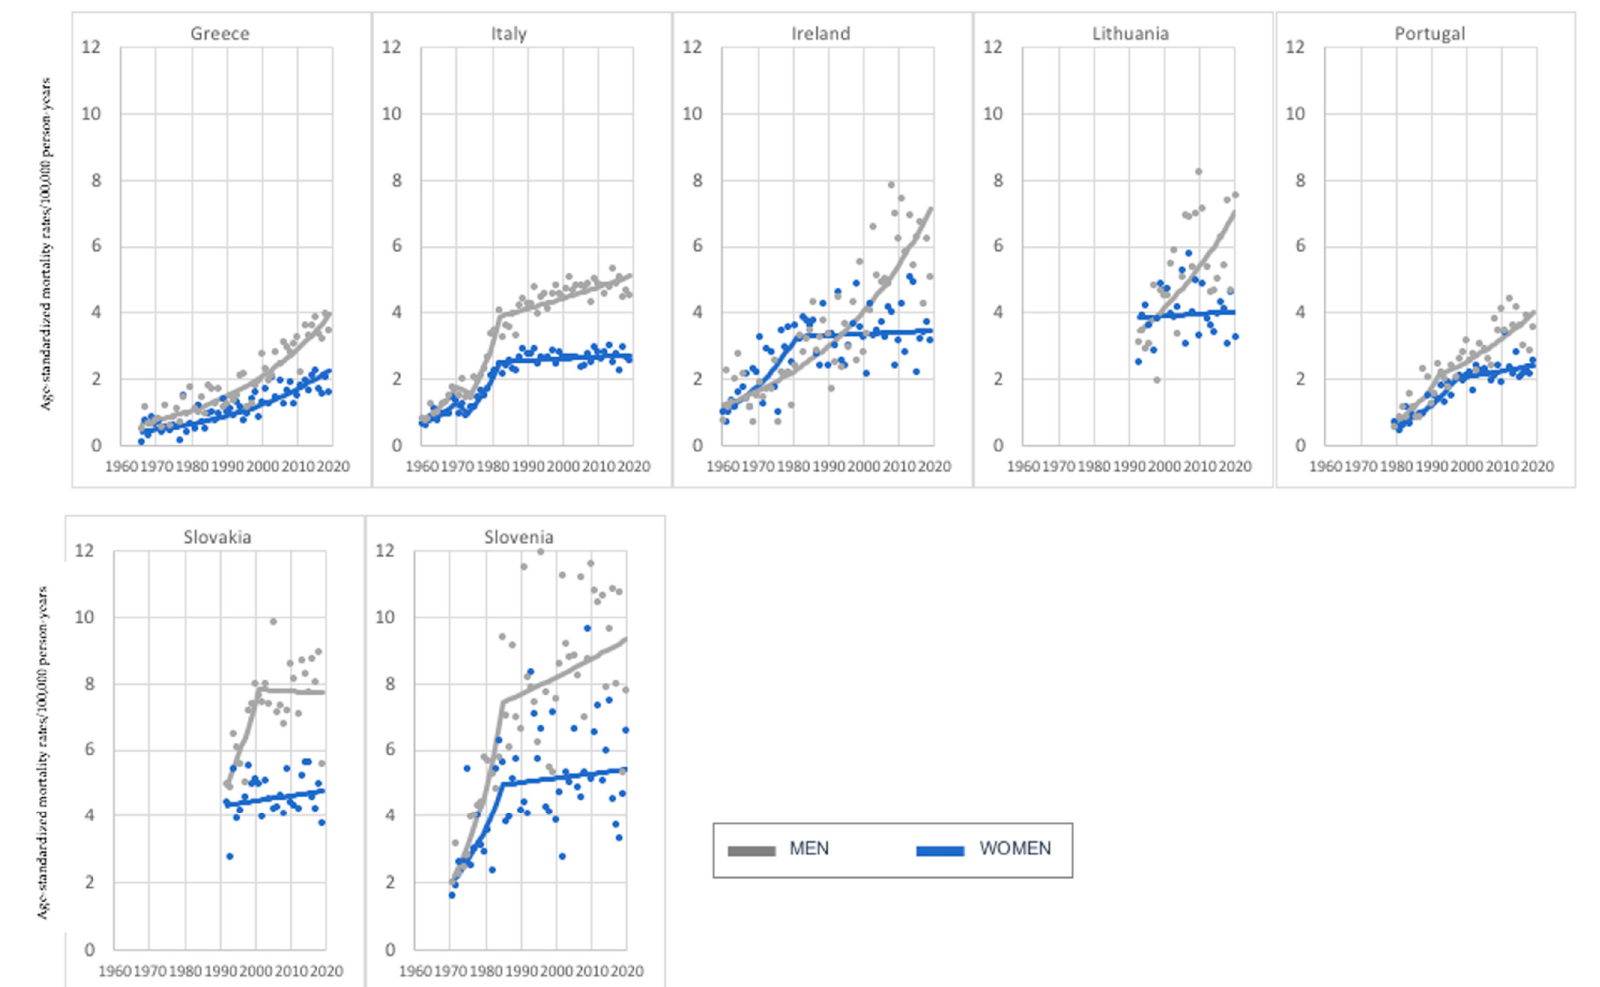
Figure 1. Melanoma mortality trends—7 countries with investigated increase in both sexes, age group 45–74 years old.